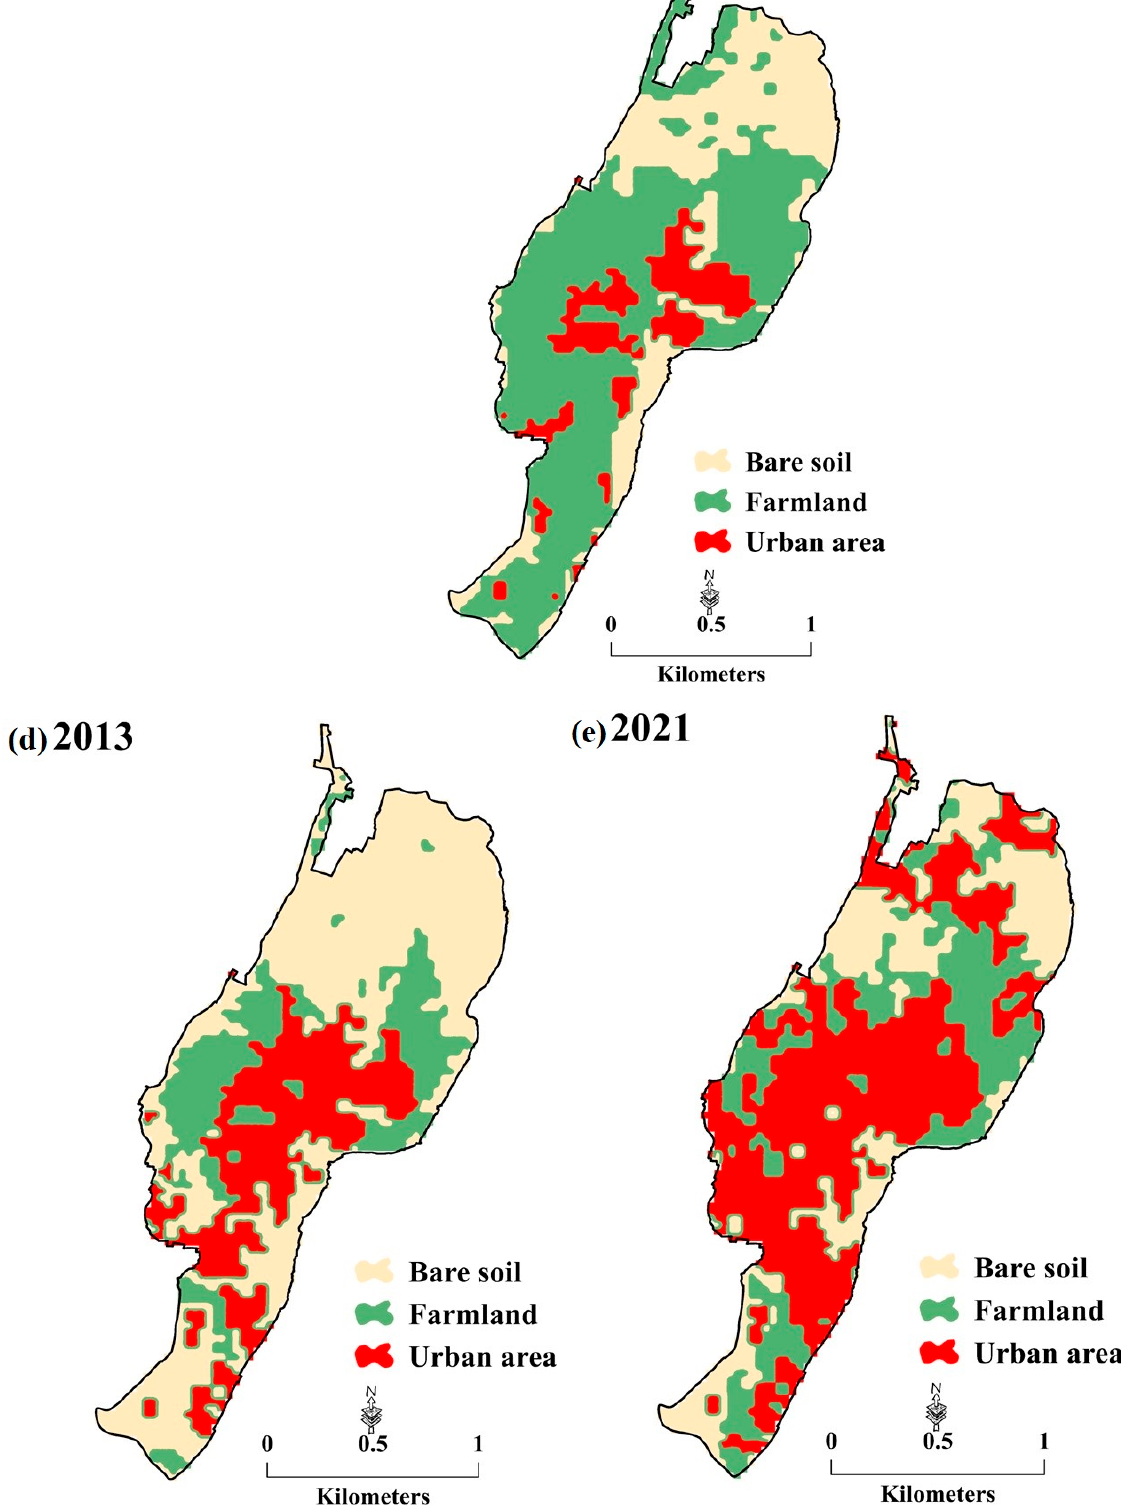
Figure 16. Bare soil (BS), urban area (UA), and farmland (FL) LULC classi fi cations in Falaj Al-Maliki for 1985–2021.